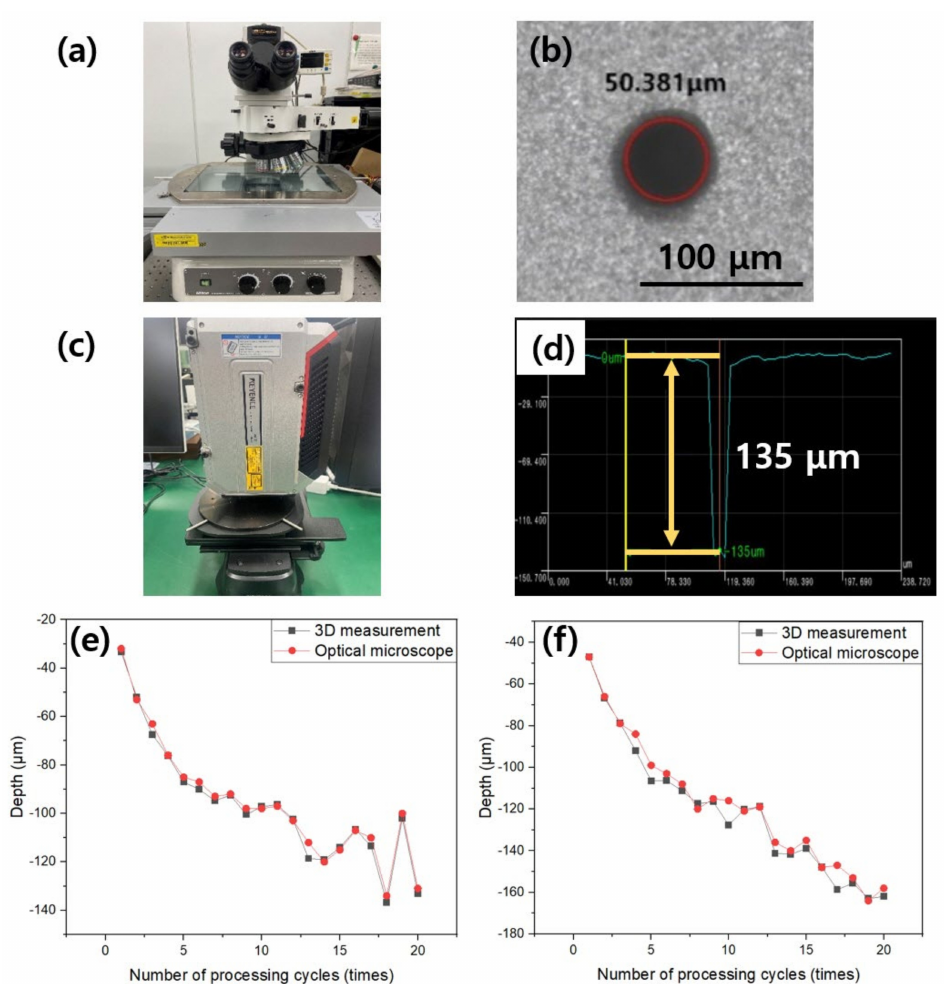
Figure 2. Equipment for measuring diameter and depth, as well as a method for analyzing hole processing geometry. ( a ) Optical microscope for diameter measurement; ( b ) diameter measurement image using an optical microscope; ( c ) interferometer for depth measurement; ( d ) depth profile measured using an interferometer; ( e ) comparison of optical microscope and interferometric depth measurement according to the number of processing cycles under a of laser power of 105 mW; ( f ) comparison of optical microscope and interferometric depth measurements according to the number of processing cycles under a laser power 130